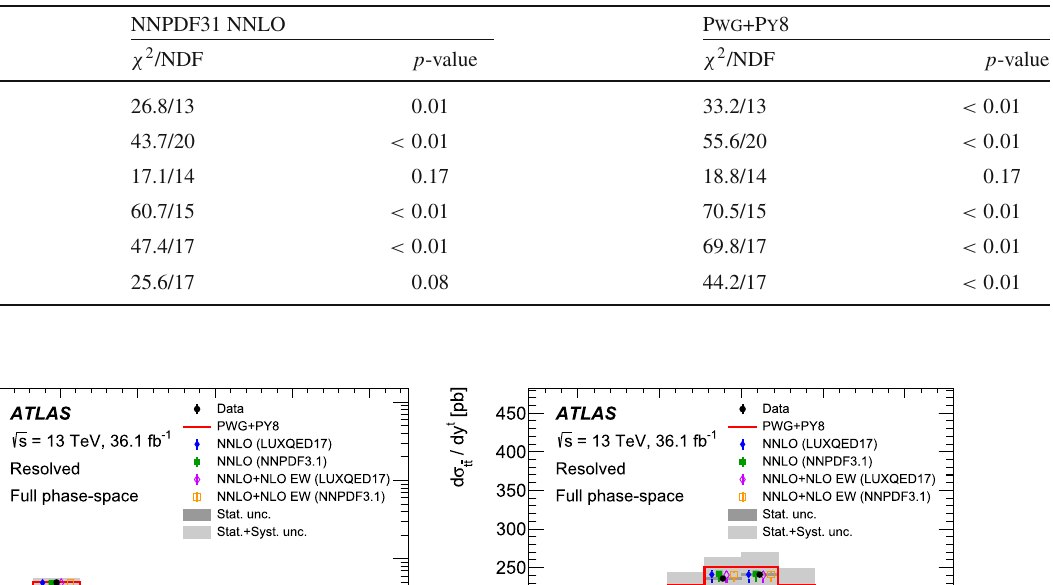
Table 24 Comparison of the measured parton-level absolute double- differential cross-sections in the resolved topology with the NNLO pre- dictions and the nominal Powheg + Pythia8 predictions. For each pre-